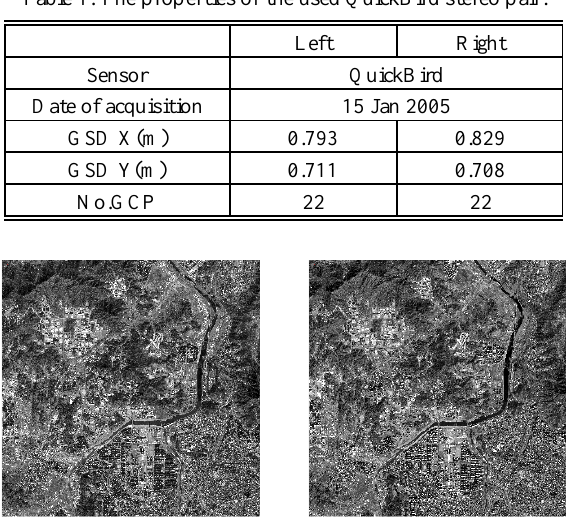
Figure 2. IKONOS stereo pair over Daejeon, Korea Table 2. The properties of the used IKONOS stereo pair.